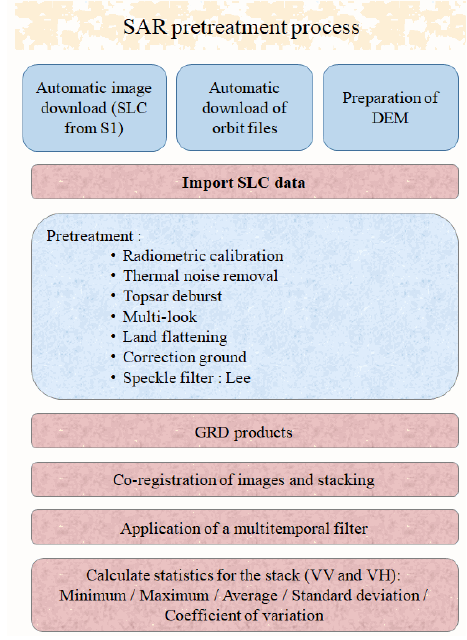
Figure 3 . SAR pre-treatment process before classification